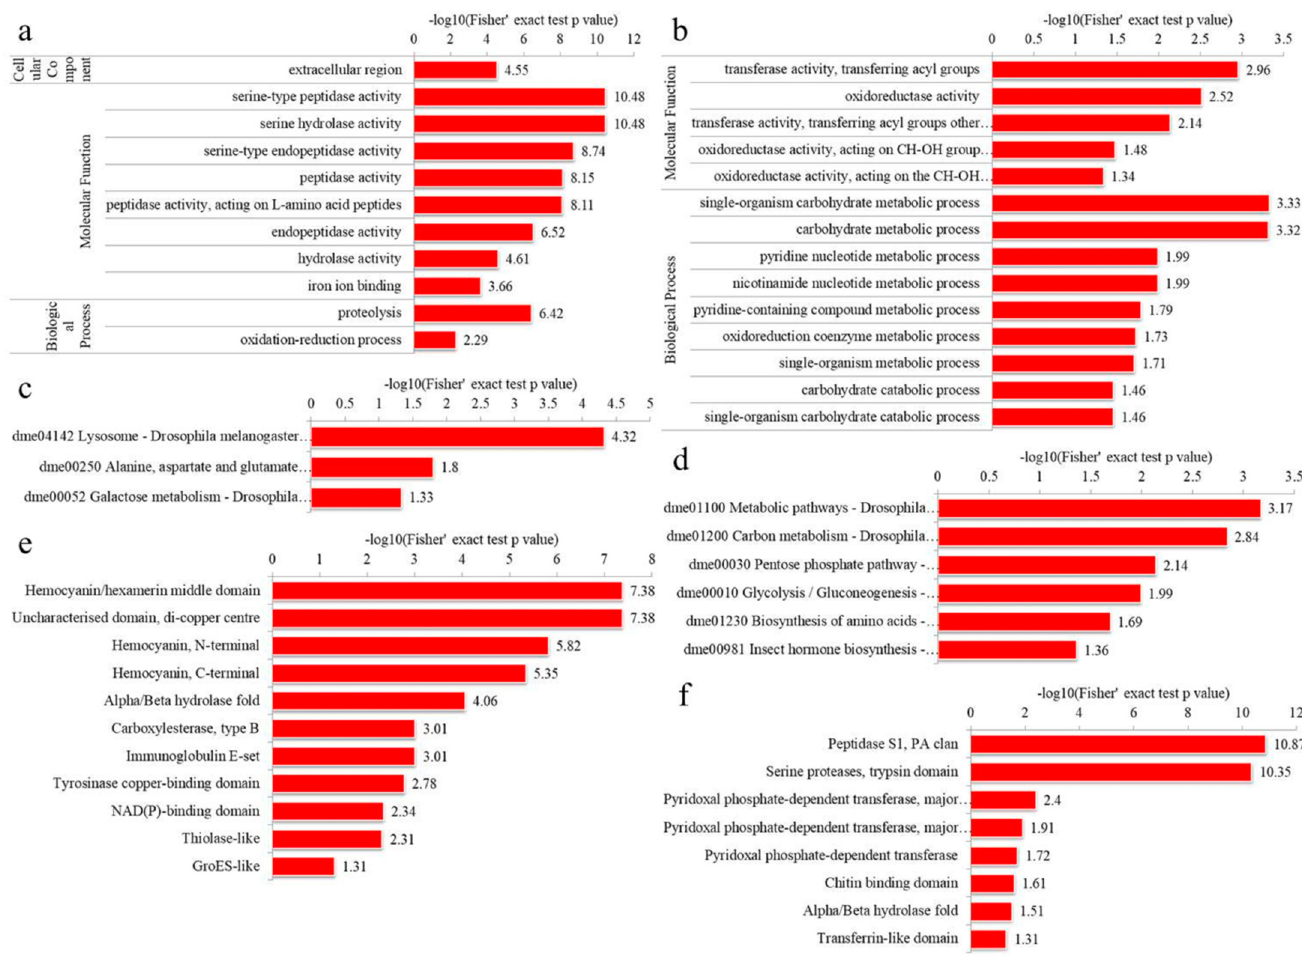
Figure 7. Enrichment analysis of the DEPs in IADA/COSMA group: ( a ) A GO-based enrichment analysis of the up-regulated DEPs; ( b ) A GO-based enrichment analysis of the down-regulated DEPs; ( c ) KEGG pathway enrichment analysis of the up-regulated DEPs; ( d ) KEGG pathway enrichment analysis of the down-regulated DEPs; ( e ) protein domain enrichment analysis of the down-regulated DEPs; ( f ) protein domain enrichment analysis of the up-regulated